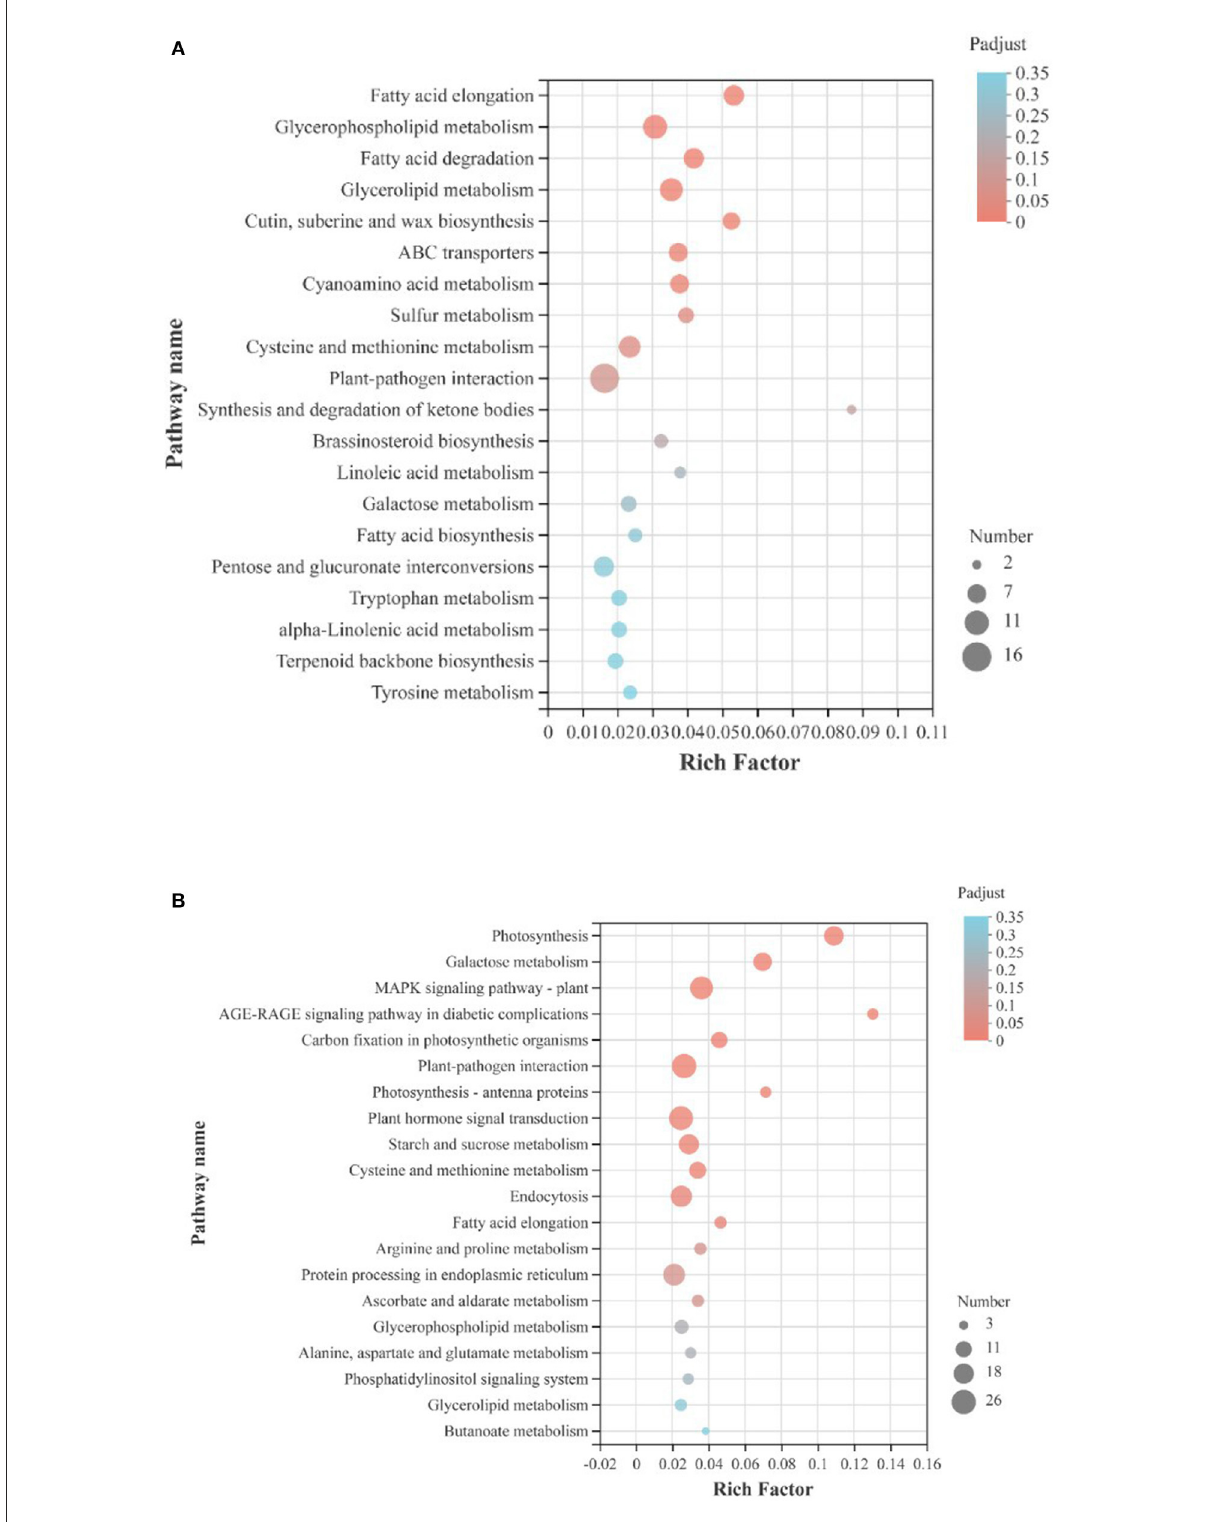
FIGURE7 KEGG pathway enrichment analysis of DEGs (|log2FC| > 1, p -adjust < 0.05) in strawberry fruit after ultrasound treatment. (A) Upregulated genes; (B) downregulated genes. Rich Factor refers to the ratio of genes enriched in the KEGG pathway to annotated genes. The greater the Rich Factor value, the higher the degree of enrichment. The size of the dot indicates the number of genes in the KEGG pathway, and the color of the dot indicates different p-adjust values. The smaller the p -adjust value, the higher the degree of